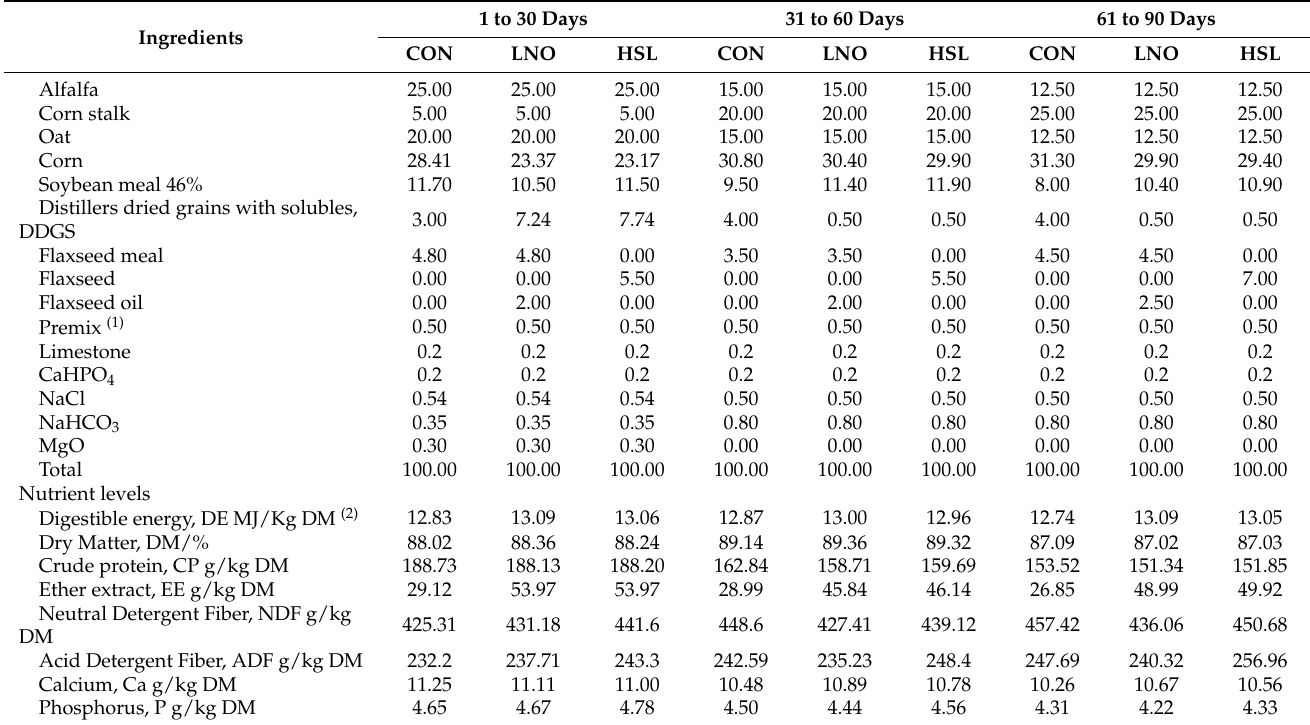
Table 1. The composition and nutrient levels of CON, LNO, and HLS group (dry-matter basis, DM